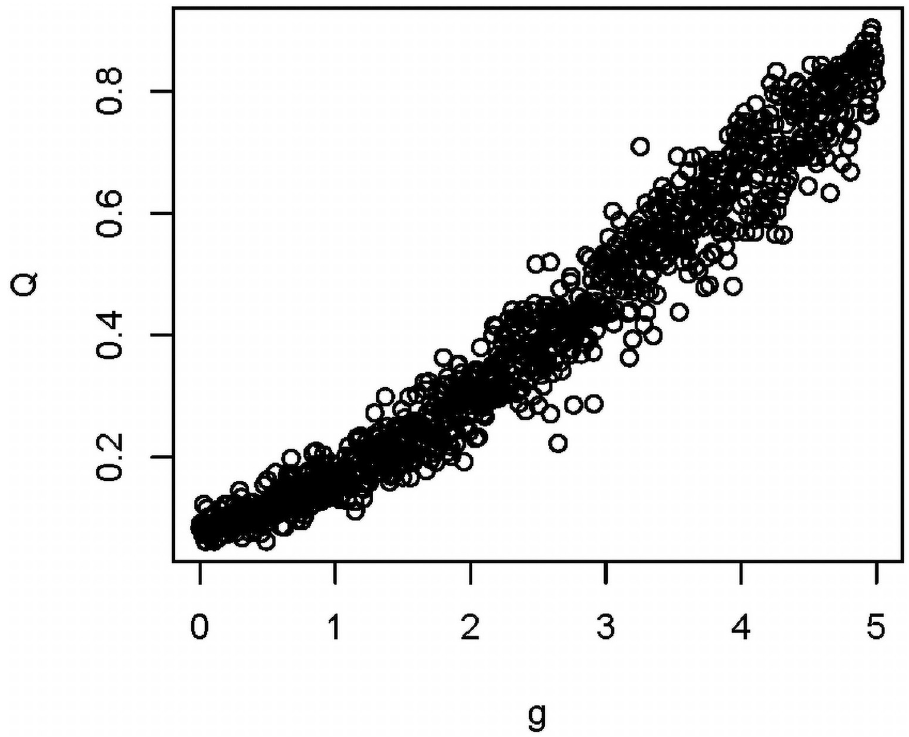
Fig 6. Relationship between host specificity ( g ) and modularity ( Q ). Data come from the 1000 simulations using the Latin hypercube sample (LHS). The measure of modularity is pre-extinction (i.e., Q 0 ).